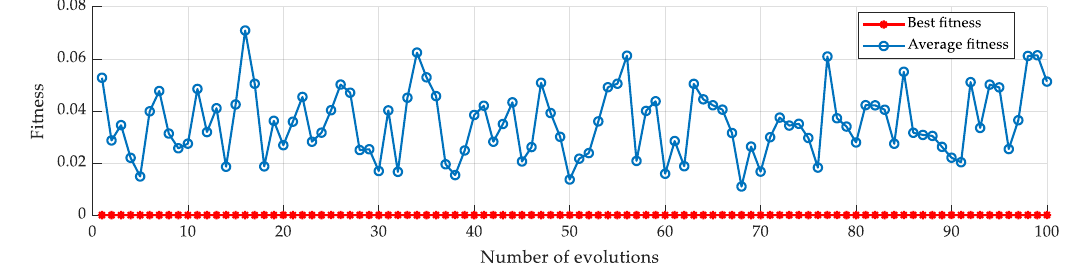
Figure 6. Parameter optimization results of PSO.